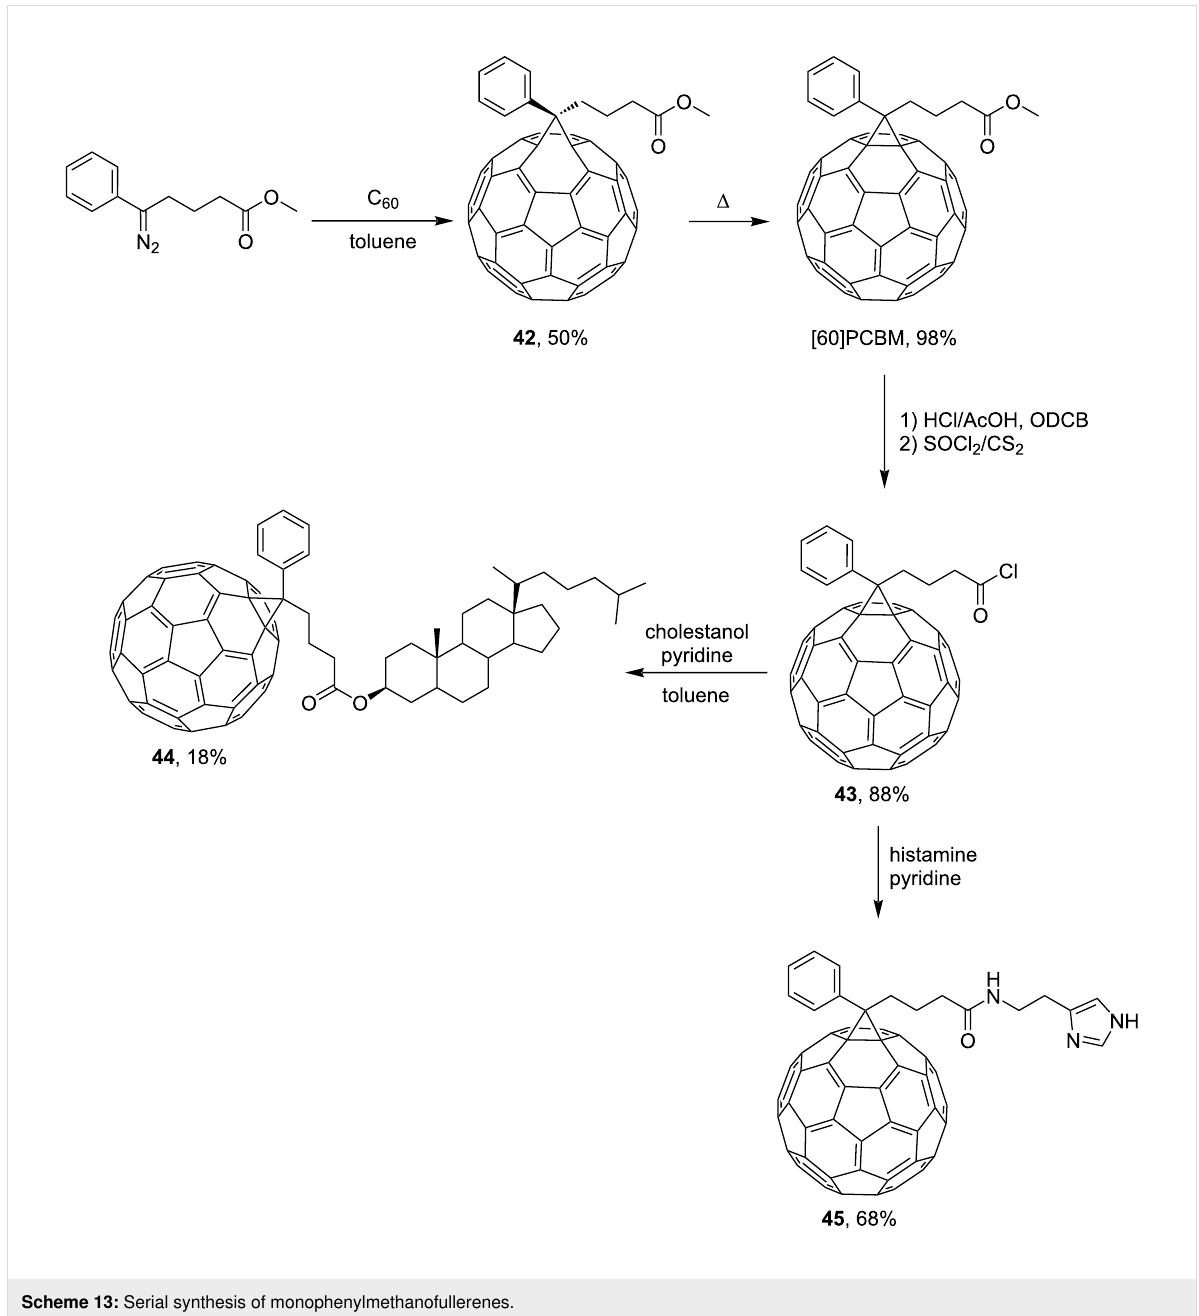
Figure 6. The syntheses of new types of N- containing fullerene ligands for metal complexes 66 – 68 are illustrated in Scheme 20